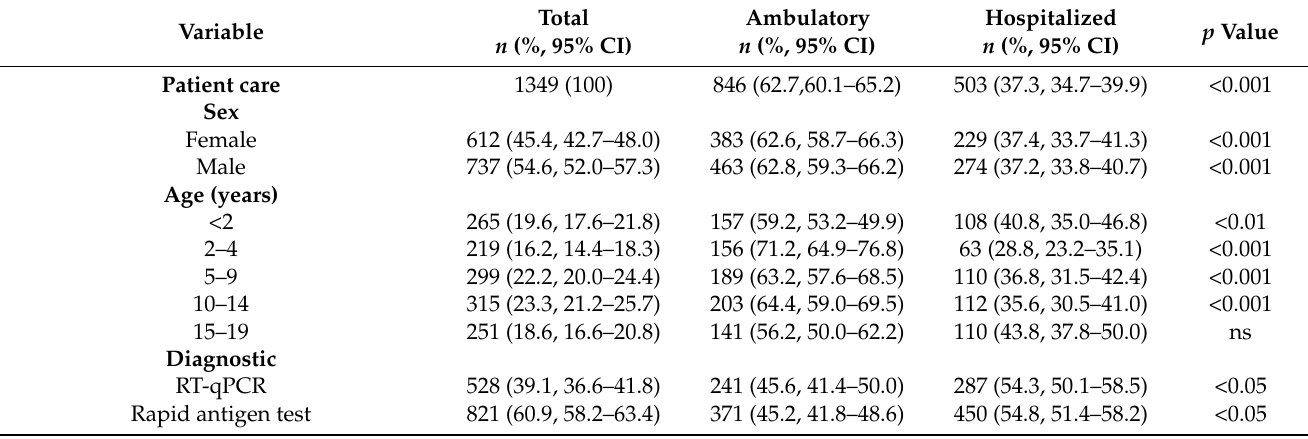
Table 1. Demographic and clinical characteristics of the population treated at the Hospital Infantil de Mexico “Federico G ó